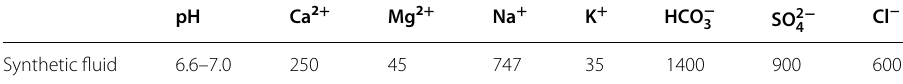
Table 1 Chemical composition of the testing fluid as prepared in the laboratory at room temperature. The concentration of the chemical species is in mg/L. The pH values reported here were measured at room temperature immediately after the preparation of the solutions